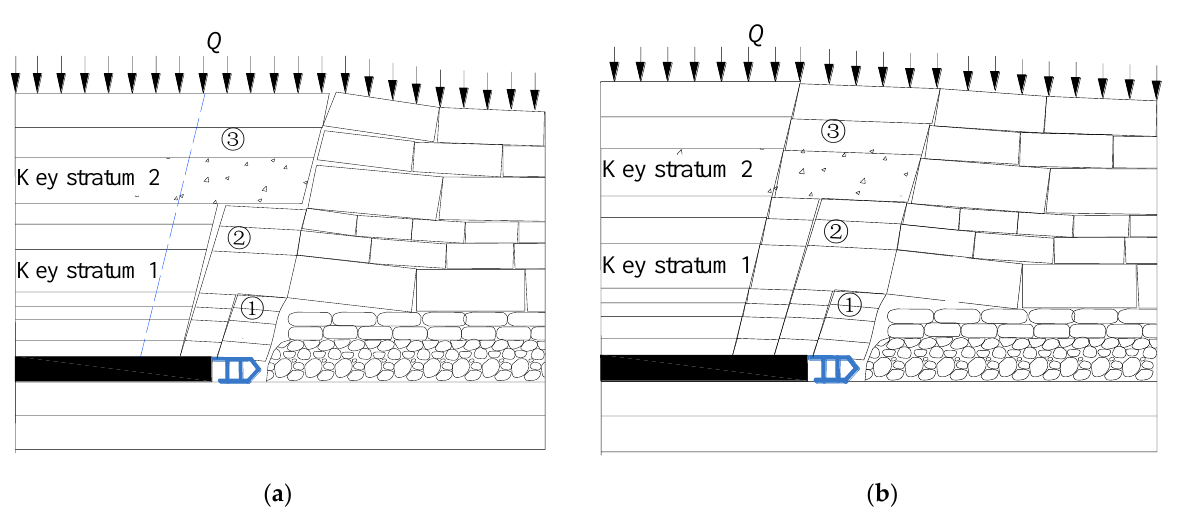
Figure 5. Fracture characteristics of large and small periodic weighing (The inclined bearing block is divided by ① , ② and ③ in the diagram). ( a ) Small periodic weighting of stope; ( b ) Large periodic weighting of stope.